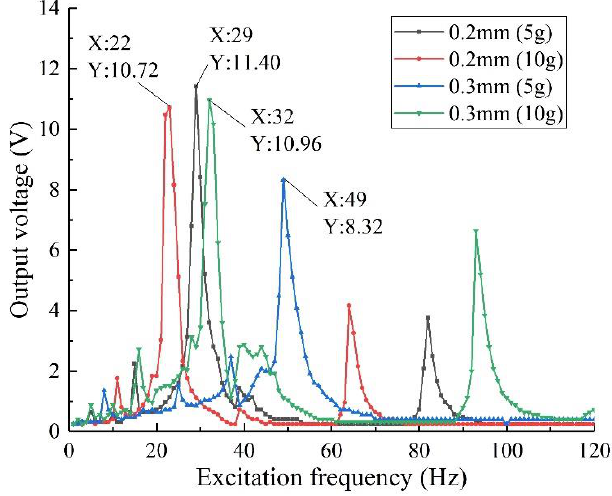
Figure 16. Output voltage of different piezoelectric substrate thickness.